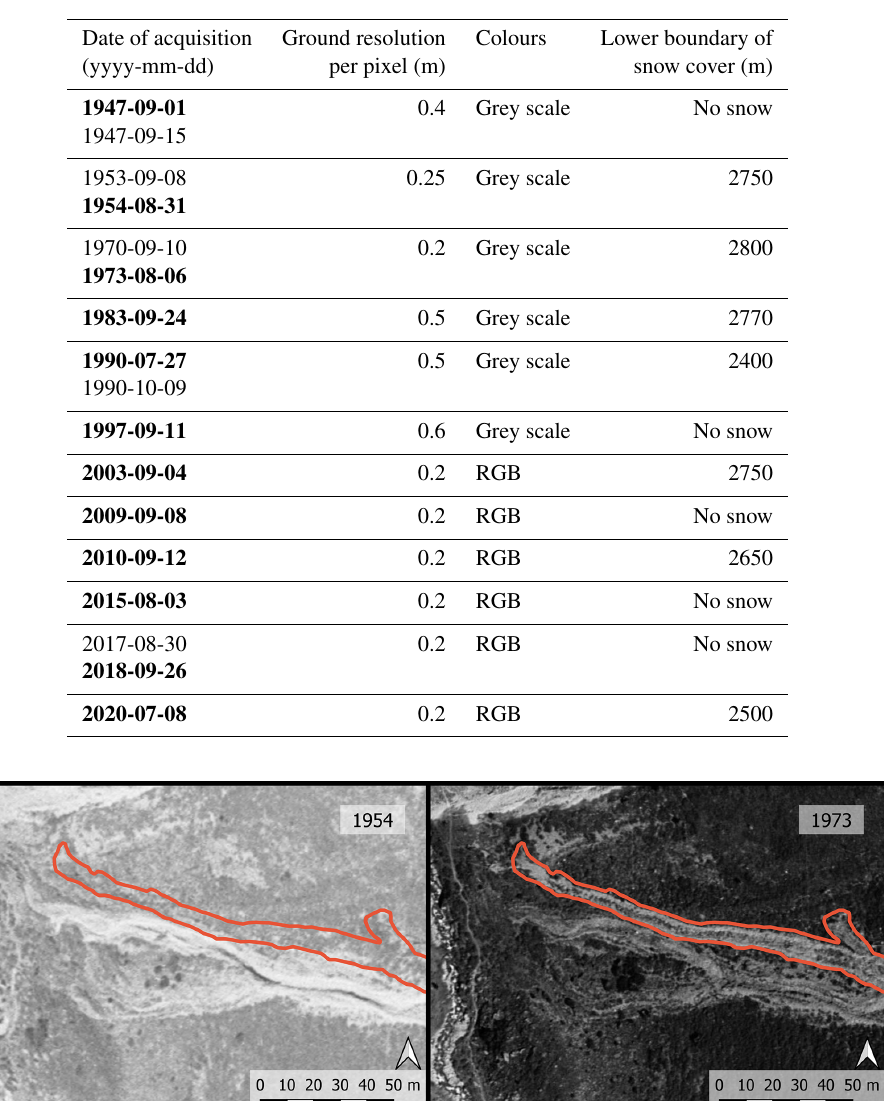
Table 2. Attributes of orthophotos used for debris flow mapping. Date of data acquisition for each time step, which covers most of the study area, is marked in bold.